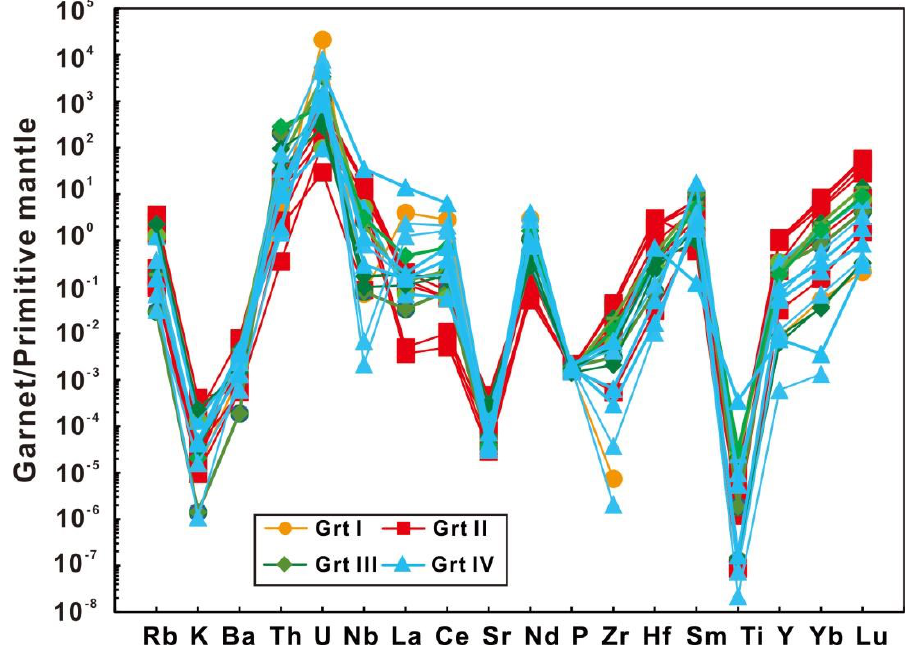
Figure 11. Trace element spider diagram of the garnets from the Huanggang deposit. Samples were normalized to the primitive mantle values of Sun and McDonough, 1989 [4 0 ].